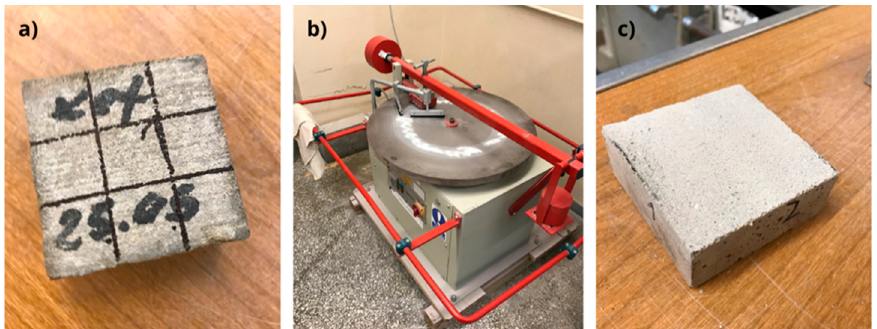
Figure 3. Photos from research conducting the ( a ) sample before the abrasion resistance test, the ( b ) abrasion resistance test, and the ( c ) sample after the abrasion resistance test.